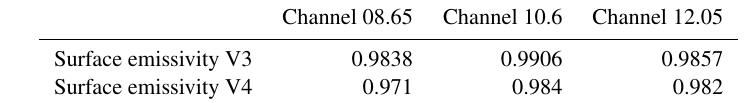
Table 1. Surface emissivity over oceans in the three IIR channels in V3 and in V4.